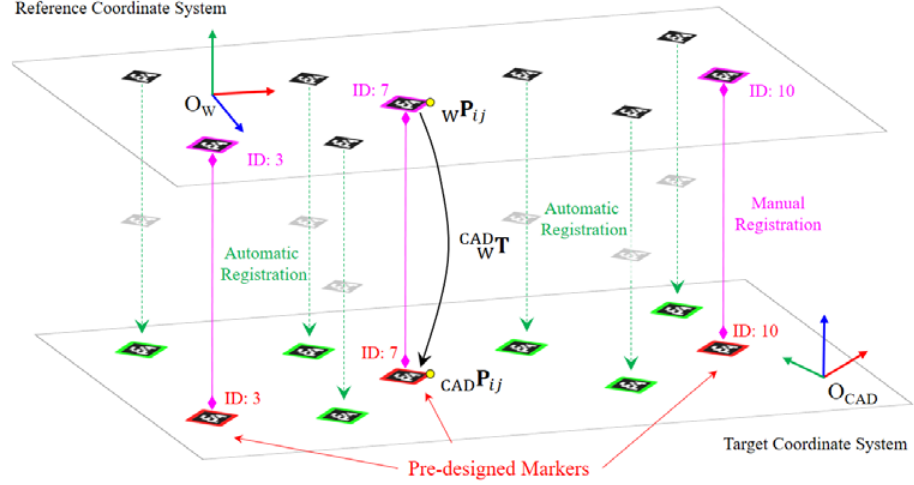
Figure 13. Concept of transforming global optimized markers into CAD coordinate system.